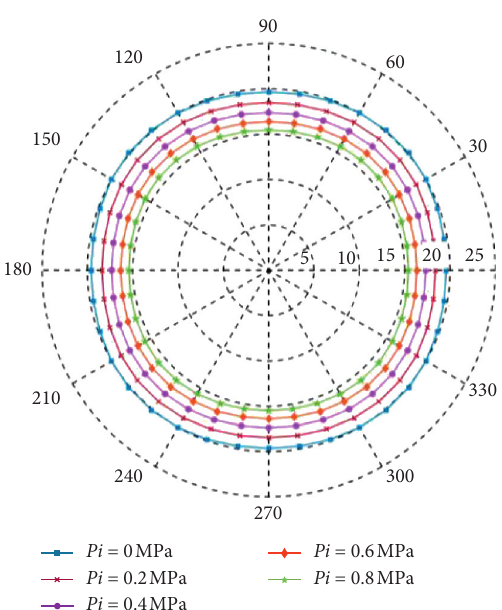
Figure 6: The influence of different support resistances on the displacement of the surrounding rock in the